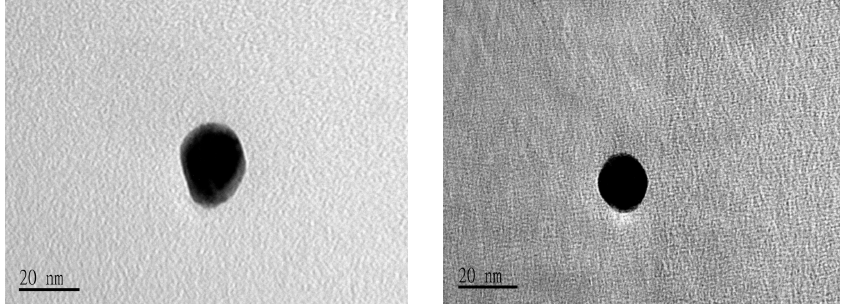
Figure 3. TEM analysis of the gold-labeled antibody. Left: a gold nanoparticle after being labeled onto antibody molecules with observable shadow around the gold sphere; Right: a gold nanoparticle before being labeled onto antibody